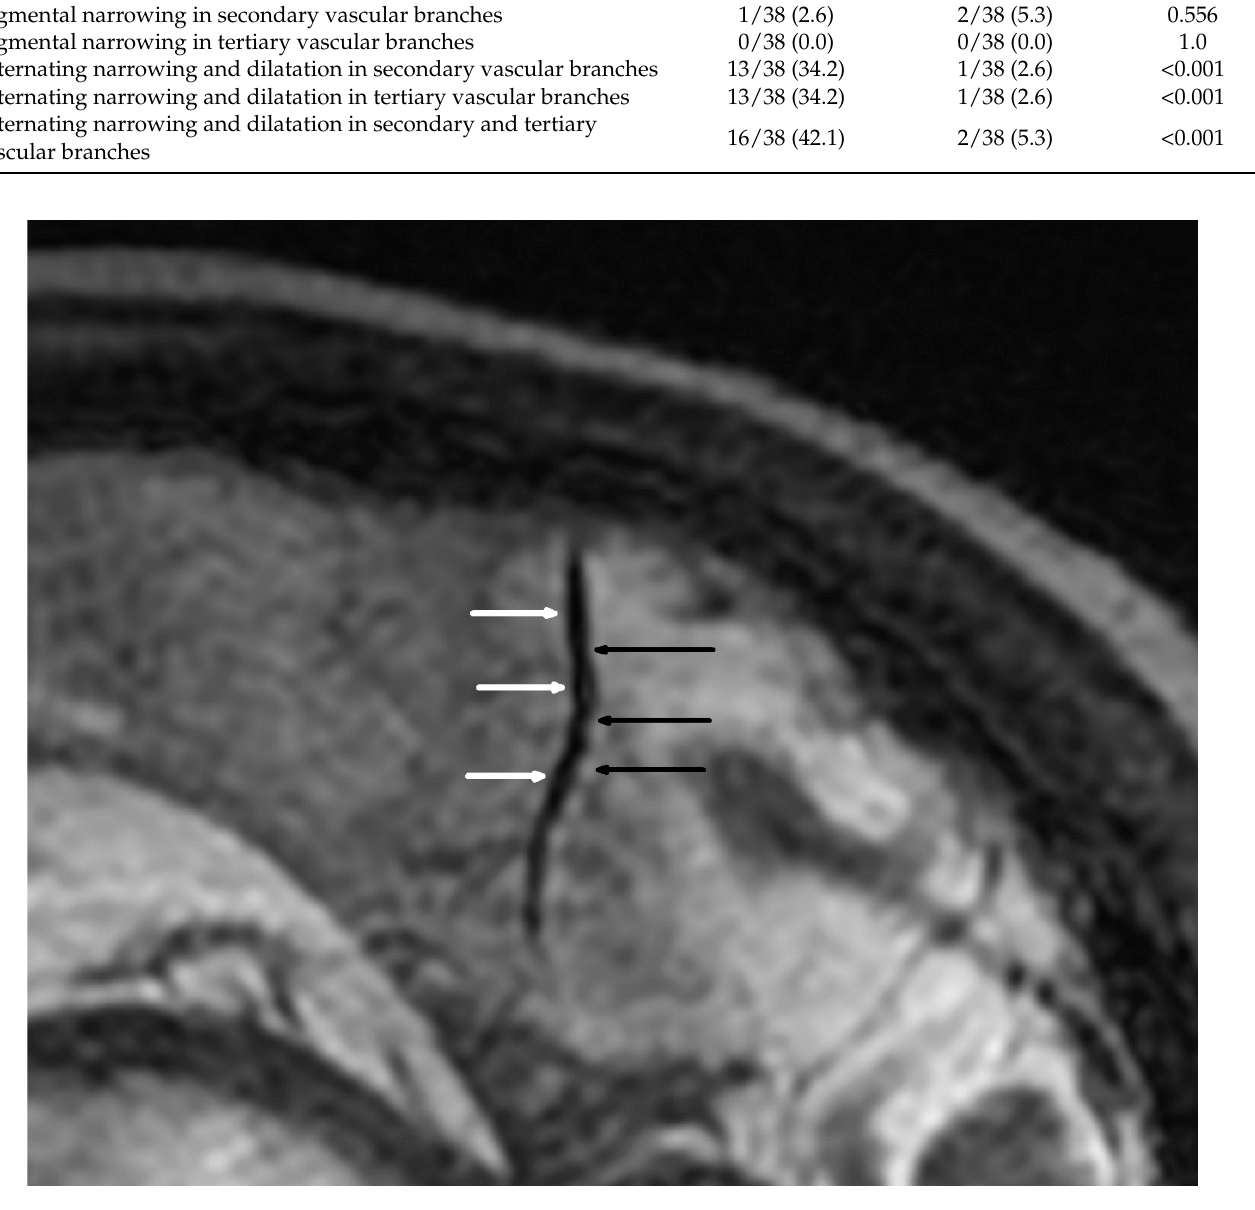
Figure 1. Alternating narrowing and dilatation in the intracranial vessel (sagittal plane). 3D Cube T2 Iso FSE sagittal sequence; black arrow—narrowing; white arrow—widening.